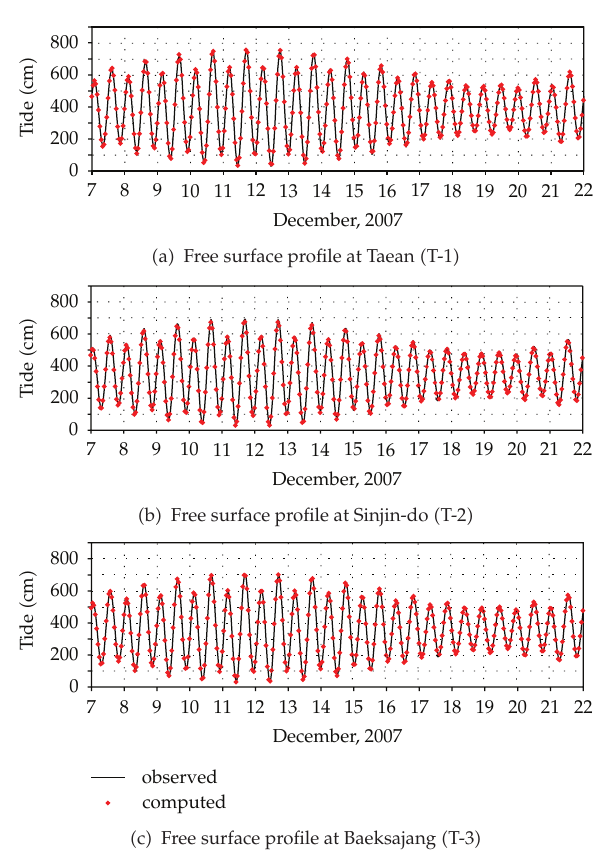
Figure 5: Comparison of observed and computed free surfaces of